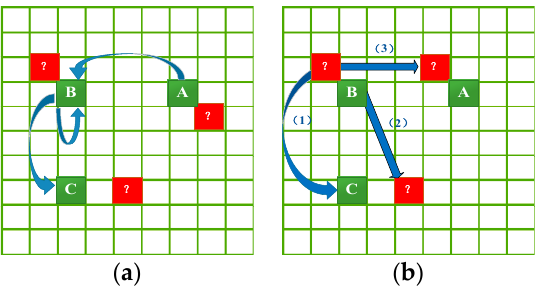
Figure 3. ( a ) No transition information for unobserved location ( b ) Transition information for unobserved location. unobserved